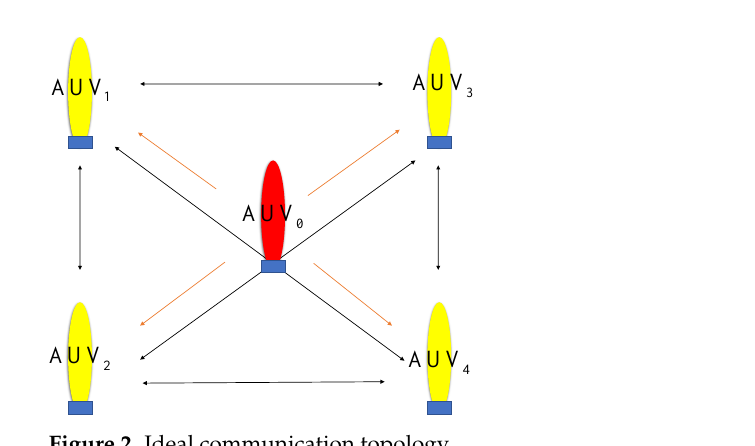
Figure 2. Ideal communication